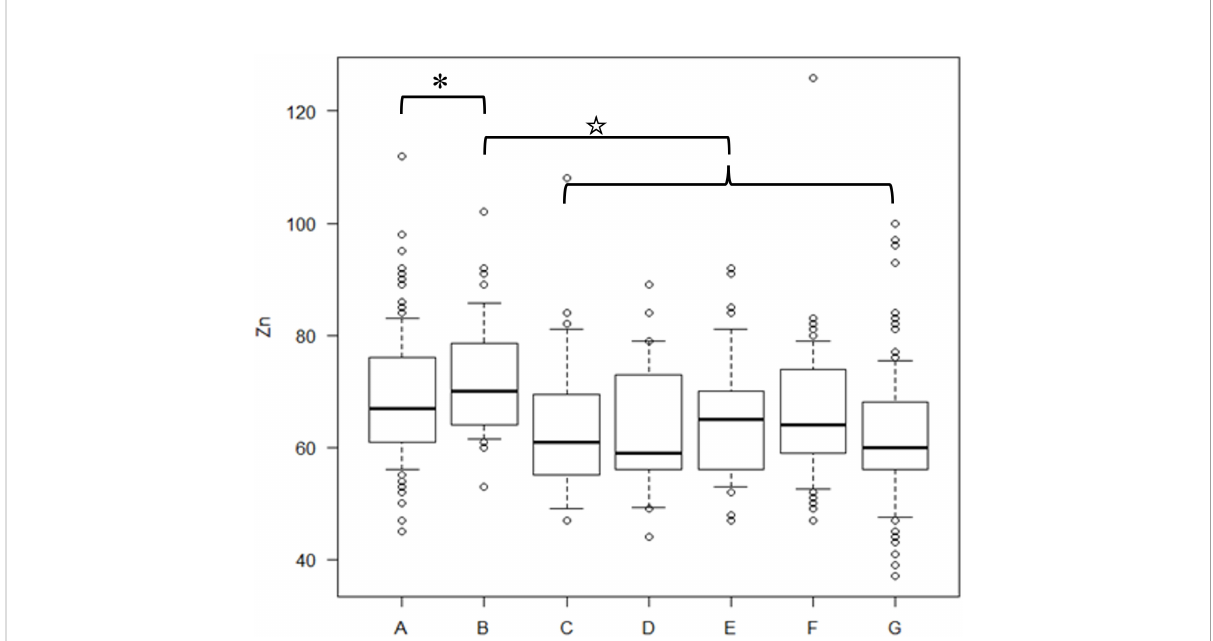
FIGURE 1 Serum zinc concentrations in cancer and non-cancer patients and cancer patients during the post-treatment period The concentration of serum zinc concentrations in each group. A) preoperative noncancer patients, B) preoperative cancer patients, C) within six months after